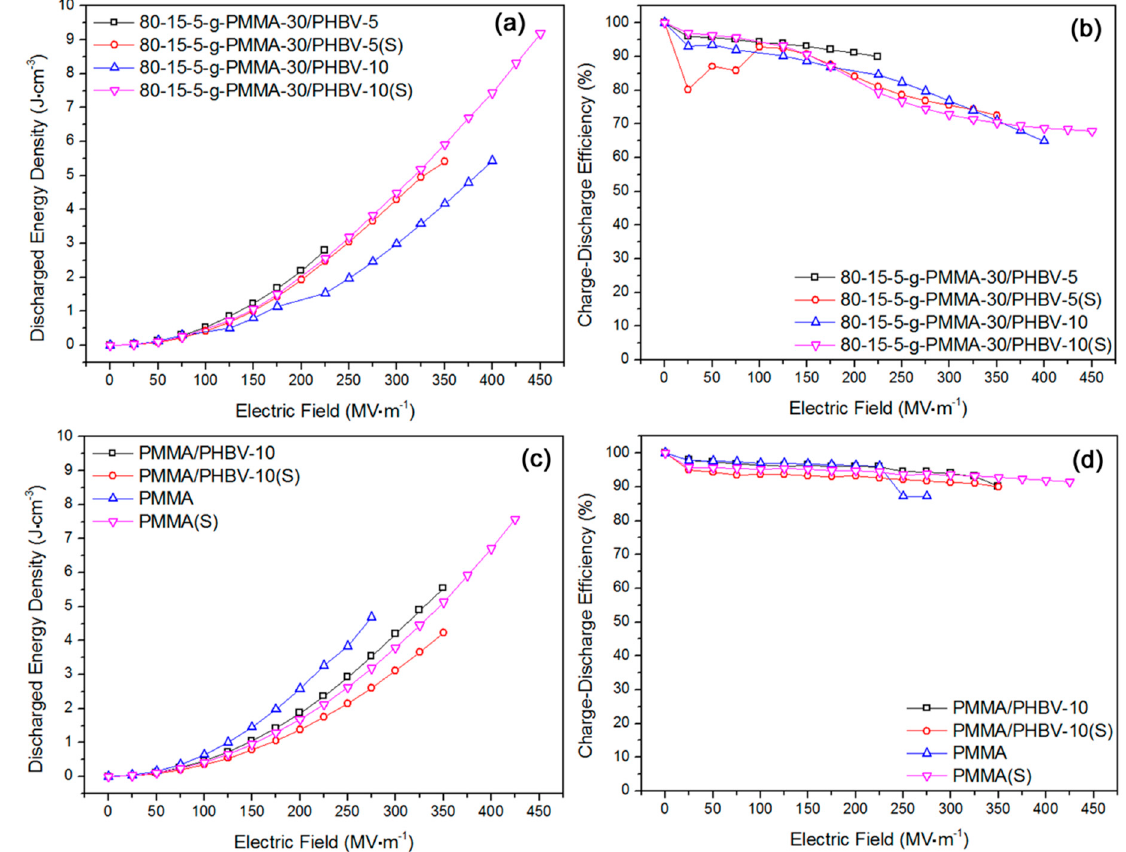
Figure 7. ( a ) High energy density was achieved in stretched 80-15-5-g-PMMA-30/PHBV-10 sample; ( b ) stretching induced reduction of charge–discharge efficiency was found for the two systems on the whole; ( c ) high energy density was obtained in stretched PMMA sample; and ( d ) insignificant influence of stretching on efficiency was verified for the two systems in wide applied field range. Table 1. Important parameters for all the samples at their own breakdown strengths.